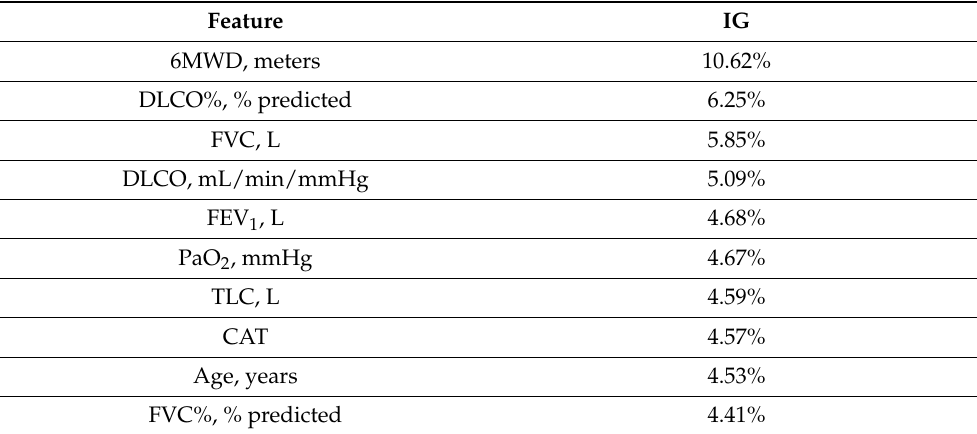
Figure 2. Confusion matrix of random forest (RF) algorithm. Table 4. Features information gain (IG) normalized and transformed into percentage for the 10 most important features chosen for